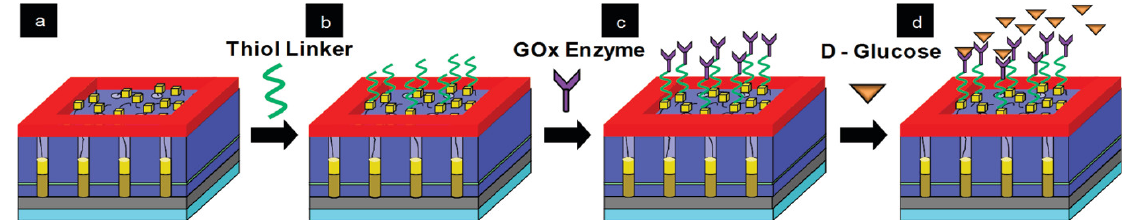
Figure 38. Schematic representation of the electrode bio-conjugation process steps to develop the glucose biosensor. ( a ) SWCNTs grown from the pores of the PAA via MPCVD with decorated Pd/Pt (Pd to form Pd nanowires in pores and Pd nano-cubes on SWCNTs), further electrodeposition is also implemented to coat the Pd or Pt nano-objects. Al2O3 is patterned to define electrode surface area. ( b ) thiol covalent linking of dithiobis (succinimidyl undecanoate) to Au/Pd nano-cubes or Au/Pt nanospheres. ( c ) covalent linking of GOx enzyme to thiol linker, and ( d ) attachment of d-glucose molecules to selective GOx sites. Reprinted with permission from Ref. [285]. Copyright © 2023 the American Chemical